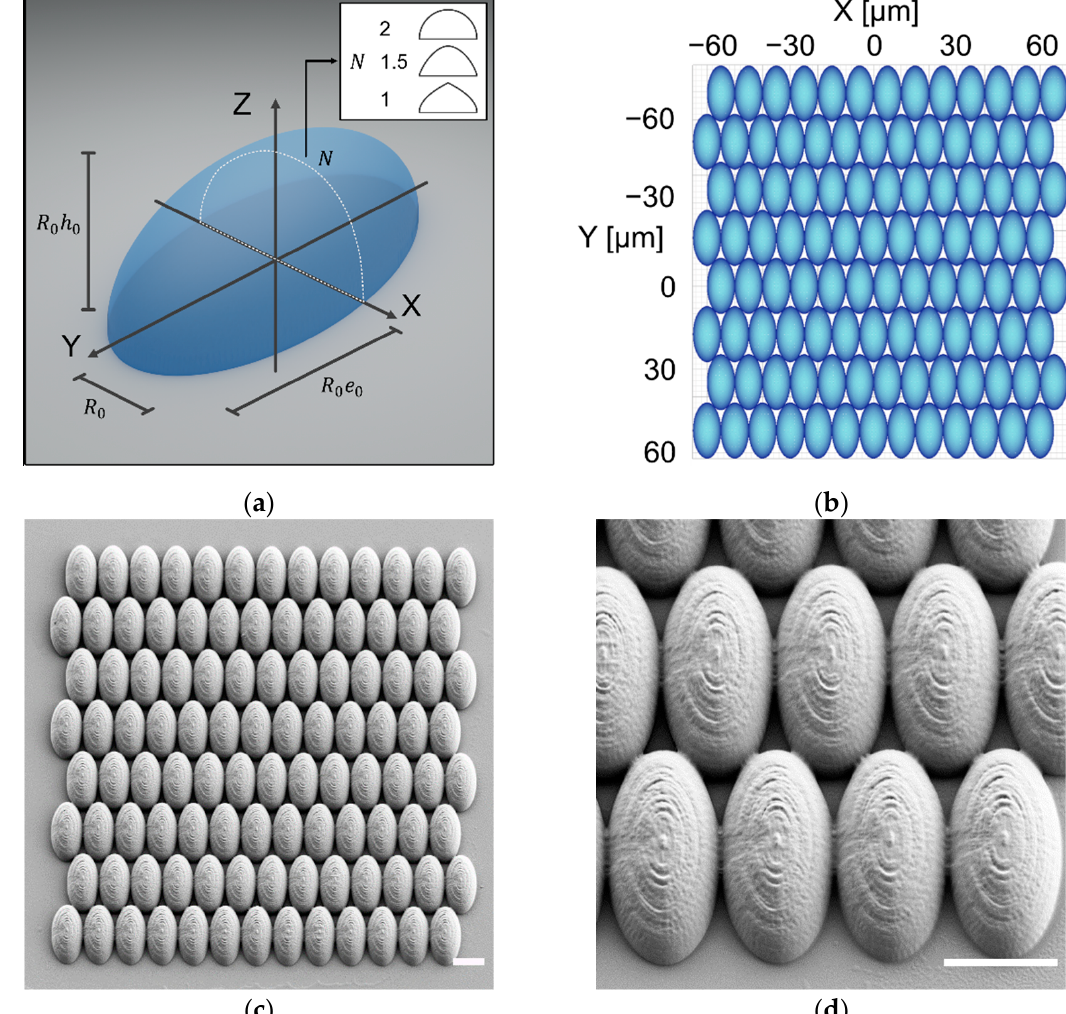
Figure 2. Microstructure fabrication process, from theoretical surface equation to 2PP 3D printing in the polyacrylate resin IP-L 780. ( a ) Single structure 3D representation with parameters from Equation (1) ( R 0 = 5 µ m, h 0 = 1, e 0 = 2, and N = 2); ( b ) 2D view of the microstructure array after importing the .STL file in the Describe software and preparation for 3D printing; ( c ) Scanning electron micrograph of the full printed array; ( d ) Scanning electron micrograph enlarged view of the singular elements of the array. The scale bar in ( c , d ) is 10 µm.